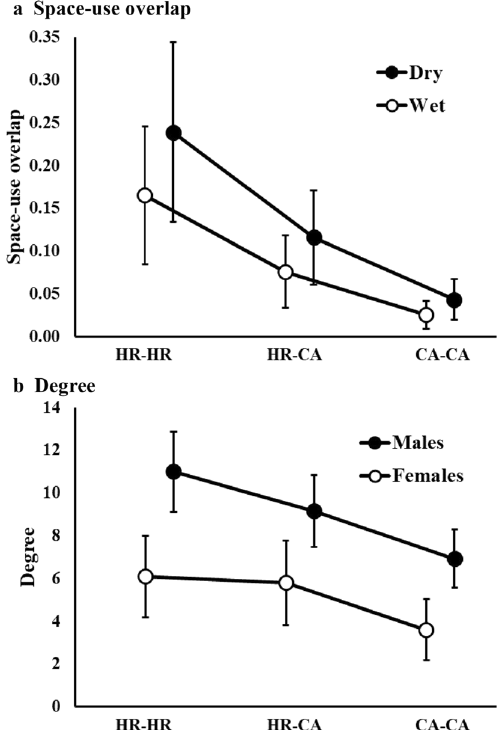
Figure 3. Space-use overlap (measured by utilization distribution of overlap index (UDOI); ( a ) and degree (number of individuals overlapped; ( b ) estimates with associated 95% confidence intervals for wild pigs at Buck Island Ranch, FL. Space-use overlap estimates come from all seasons while degree represents the Dry 2016 season which contained the greatest number of monitored individuals. Estimates were created for home range to home range (HR–HR), home range to core area (HR–CA) and core area to core area (CA–CA) overlap. Space use overlap was estimated for dry (Dry) and wet (Wet) seasons. Degree values were estimated for male (M) and female (F) wild